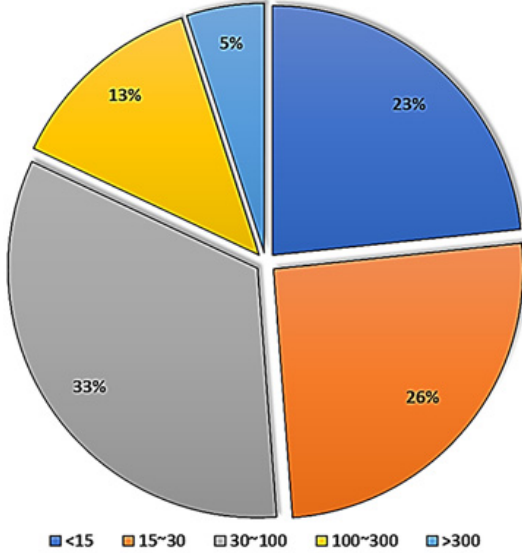
Figure 5. Enrolment of clinical trials using stem